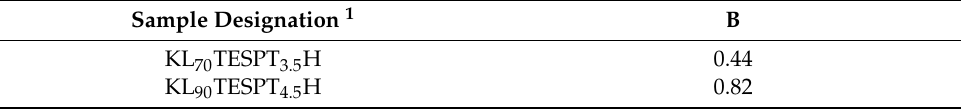
Table 4. Parameters obtained from DMA analysis.